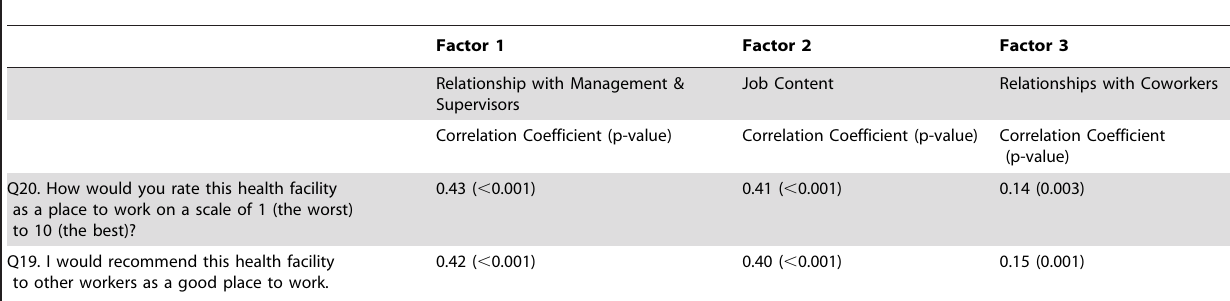
Relationships with Coworkers Correlation Coefficient (p-value) Correlation Coefficient